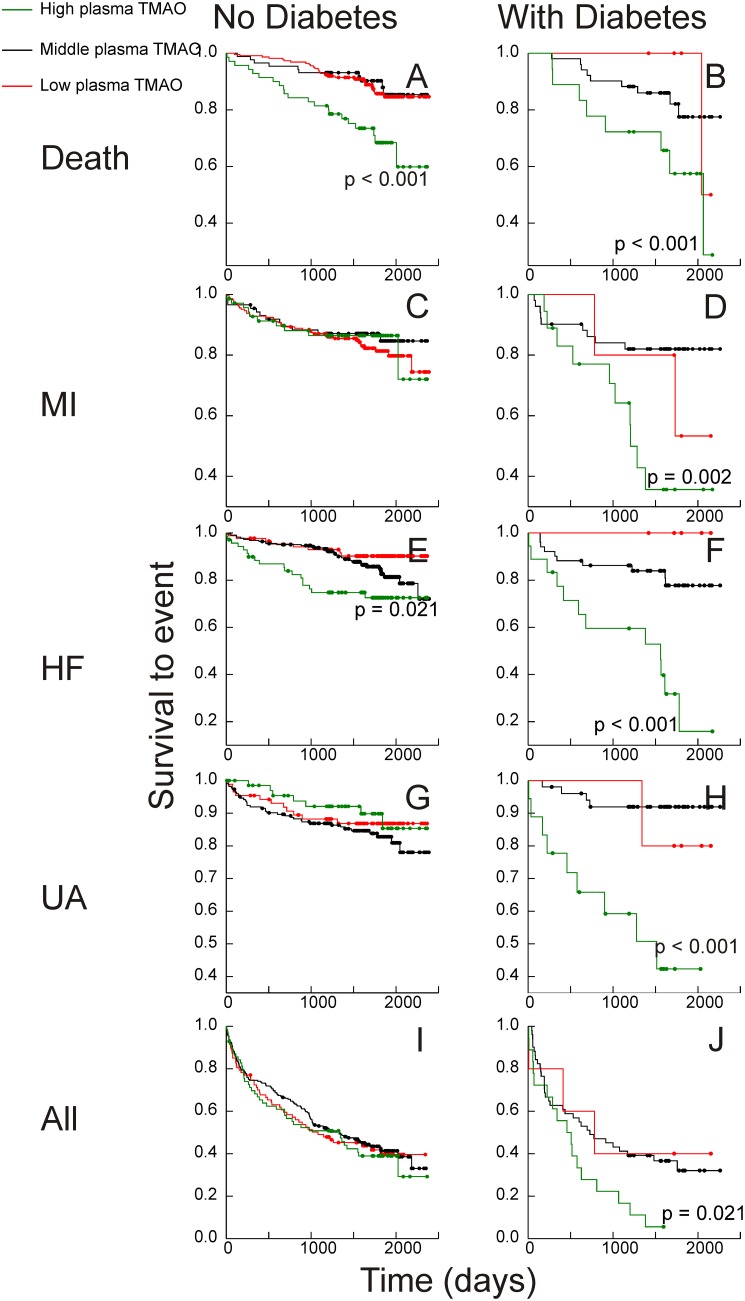
Kaplan-Meier plots: trimethylamine-N-oxide.Plasma trimethylamine-N-oxide concentrations and Kaplan-Meier plots of survival to events. TMAO: Trimethylamine N-oxide. Events: Top (A&B) death from all causes; (C&D) secondary myocardial infarction (MI); middle (E&F) hospitalization for heart failure (HF); (G&H) unstable angina (UA), and (H&I) all cardiovascular events. On left, A,C,E,G&H are subjects without diabetes; on right, B,D,F,H&J are subjects with diabetes. “High” (green) is the highest quintile of plasma betaine concentration, “Low” (red) the bottom quintile of plasma betaine concentration; “Middle” (black) the remaining 60% of the cohort. All significances are for comparisons with the middle group. Where no significance is shown, p for the difference is >0.3.